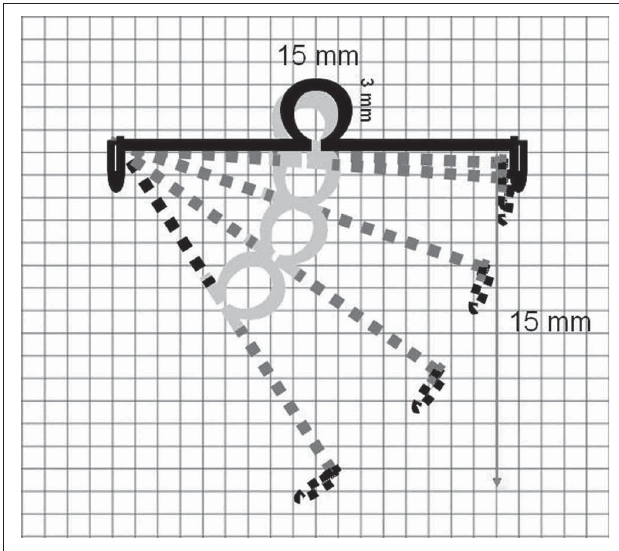
Fig. 1 : Template used to fabricate and activate the transpalatal bars under study.